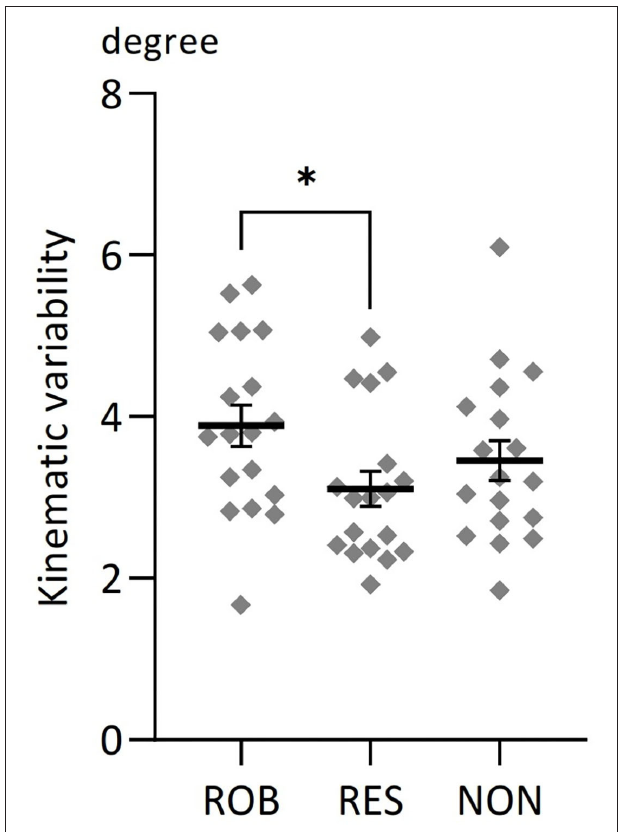
FIGURE 3 | Average changes in kinematic variability for three conditions. Comparisons of average changes in kinematic variability for ROB, RES, and NON. * p < 0.05. Data are expressed as the mean with standard error